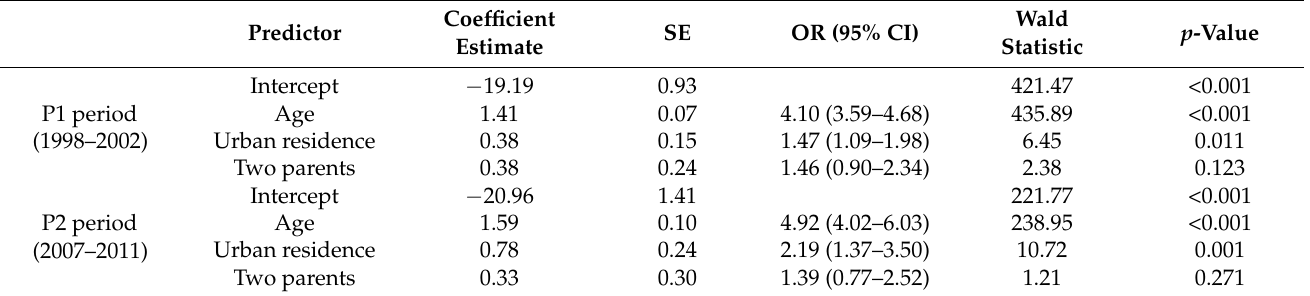
Table 5. Results of the logistic regression on the odds ratio of menarche